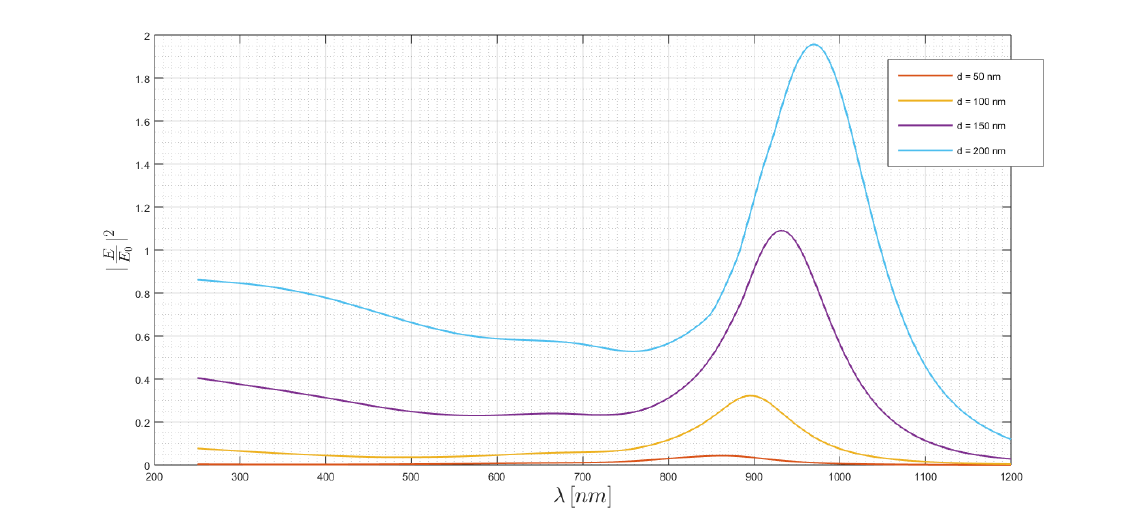
Figure 8. Hole diameter sweep on the gold nanostructure.